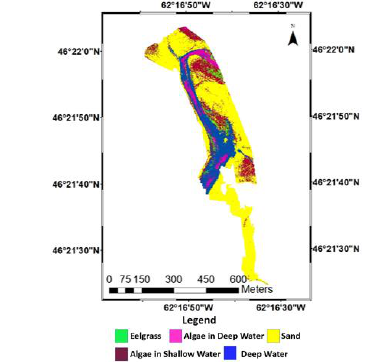
Figure 10. Classified image produced with the RF Classifier applied to all the bands of the UAV image.